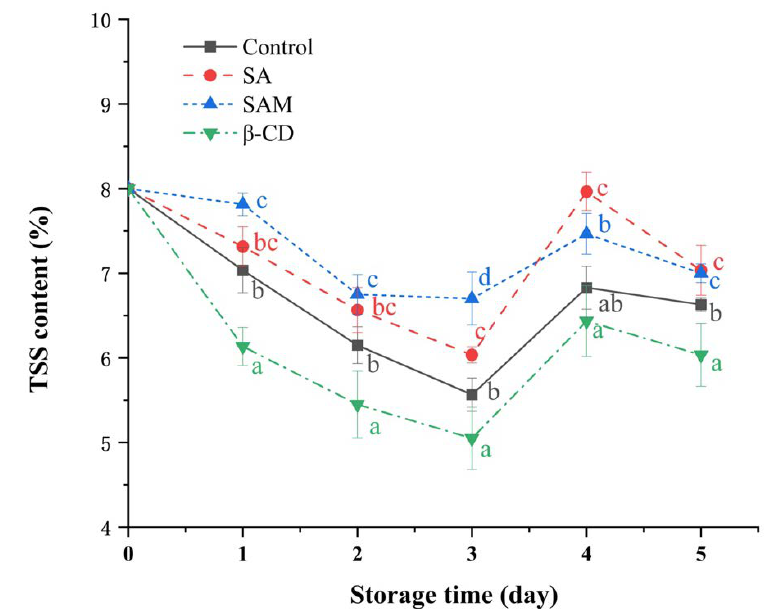
Figure 6. Effect of SAM on total soluble solid (TSS) content in ‘Fuji’ apple during 5 days of storage at 25 °C. SA, salicylic acid; SAM, salicylic acid microcapsule; β -CD, β -cyclodextrin. Control group was prepared with sterile distilled water. Vertical bars represent standard errors. Different letters within each day show a significant difference ( p < 0.05).